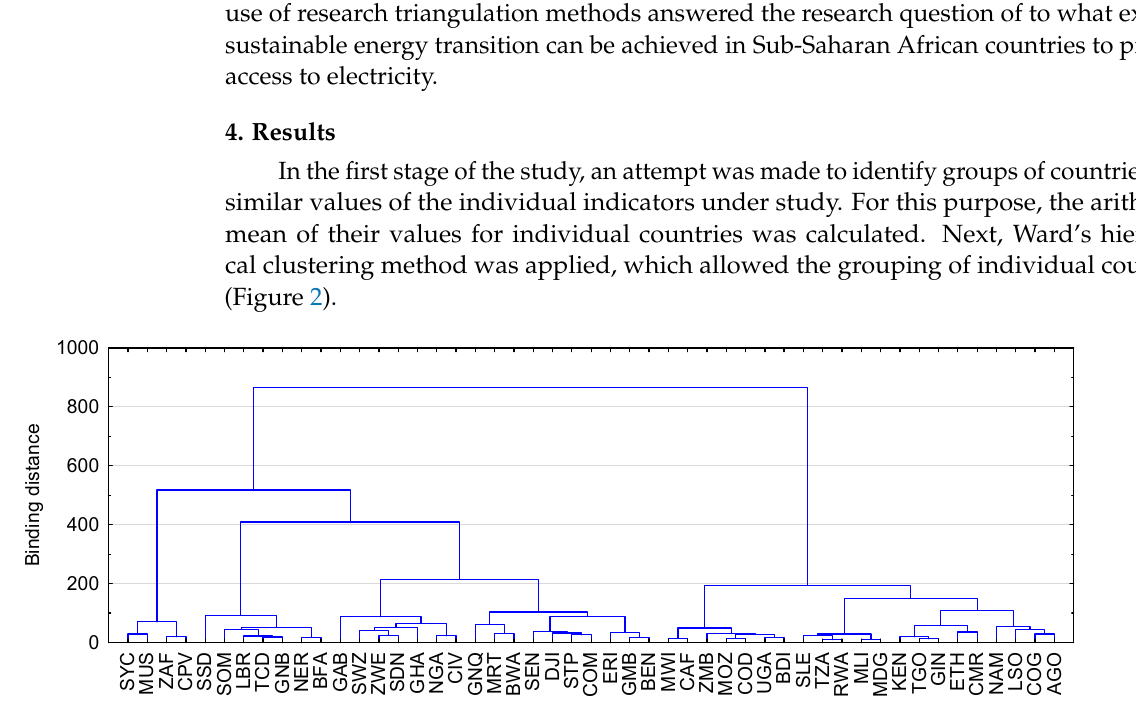
Figure 2. Classification of individual countries in relation to the level of the indicators examined. Source: own study